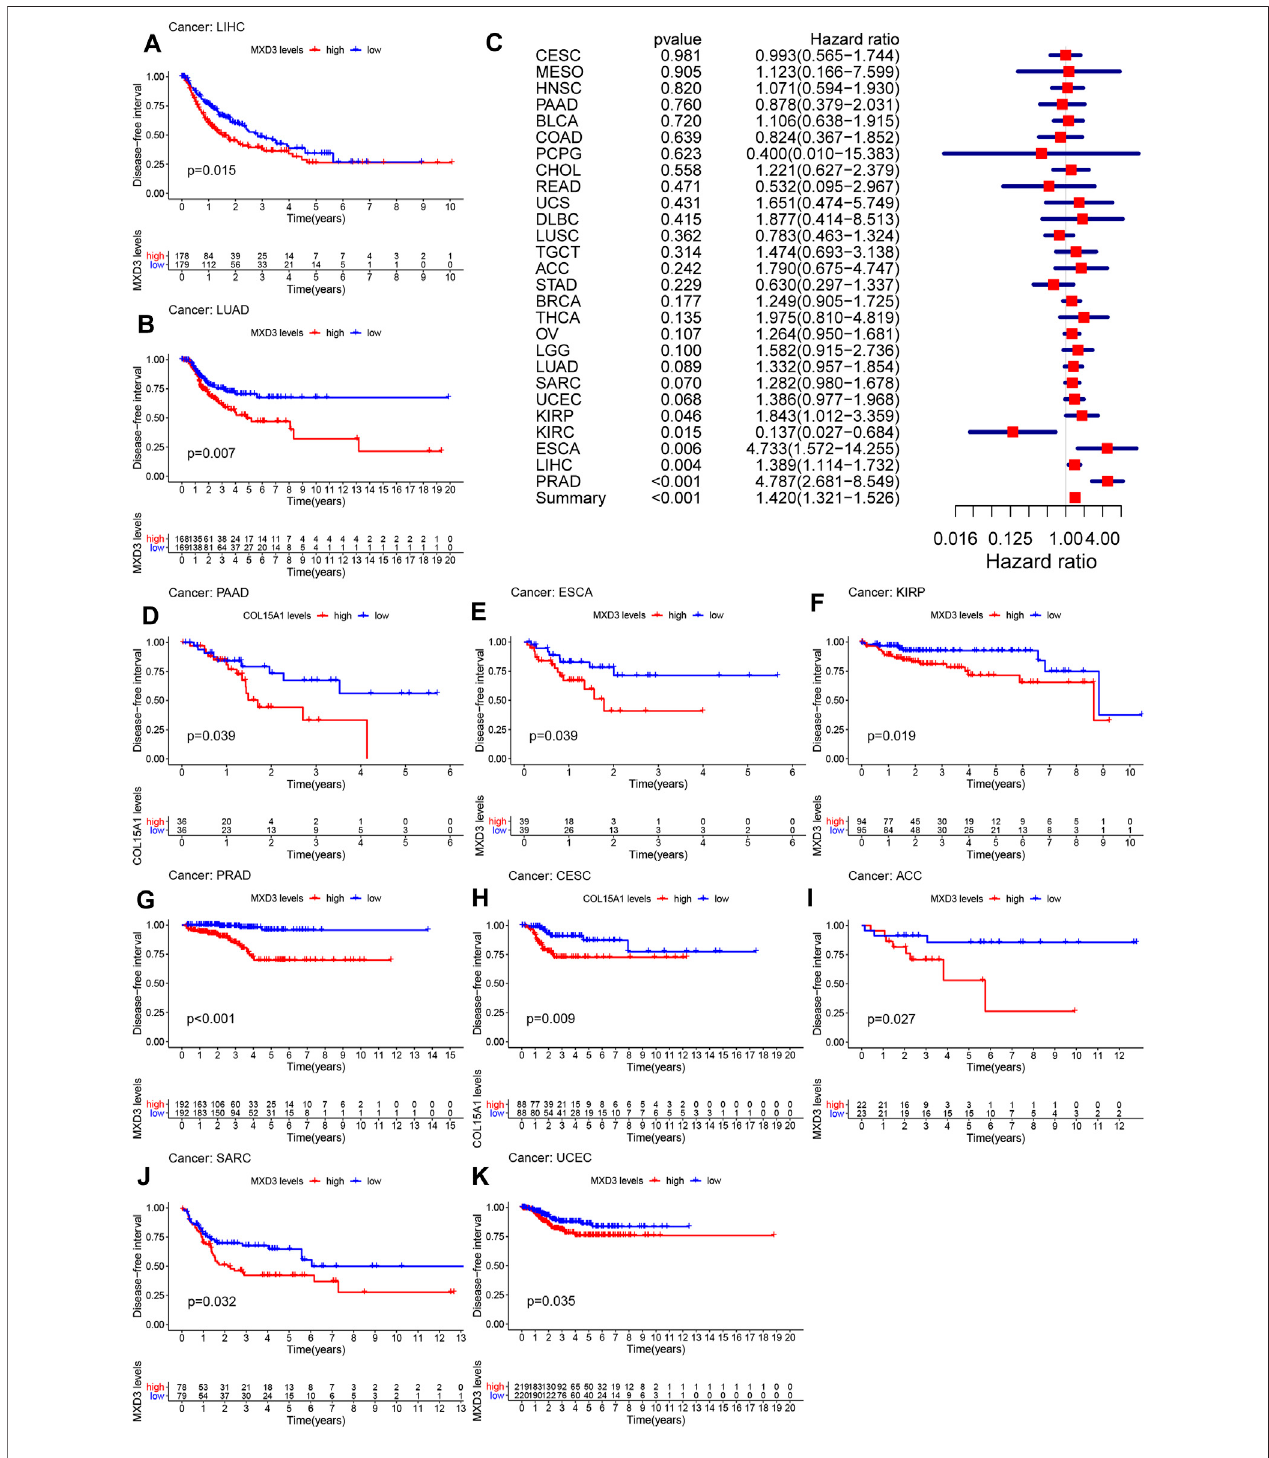
FIGURE4| DFIwithdifferentMXD3expressioninLIHC (A) ,LUAD (B) ,PAAD (D) ,ESCA (E) ,KIRP (F) ,PRAD (G) ,CESC (H) ,ACC (I) ,SARC (J) ,andUCEC (K) .Cox regression of MXD3 and DFI (C) in cancer types.